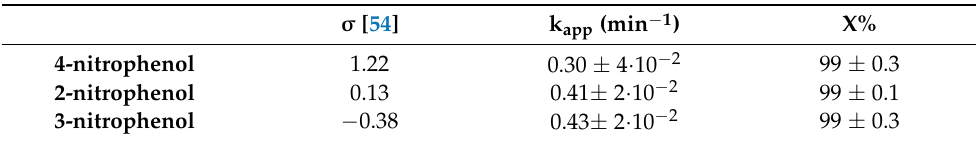
Table 13. Apparent kinetic constant and conversion for pseudo-first-order-reactions using PVA-60 with an Au/PVA weight ratio of 1.0.33.